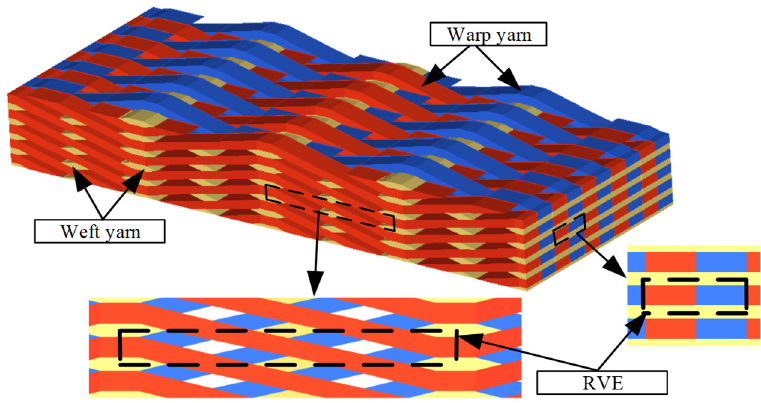
Figure 3. Geometry of 2.5D braided composite.